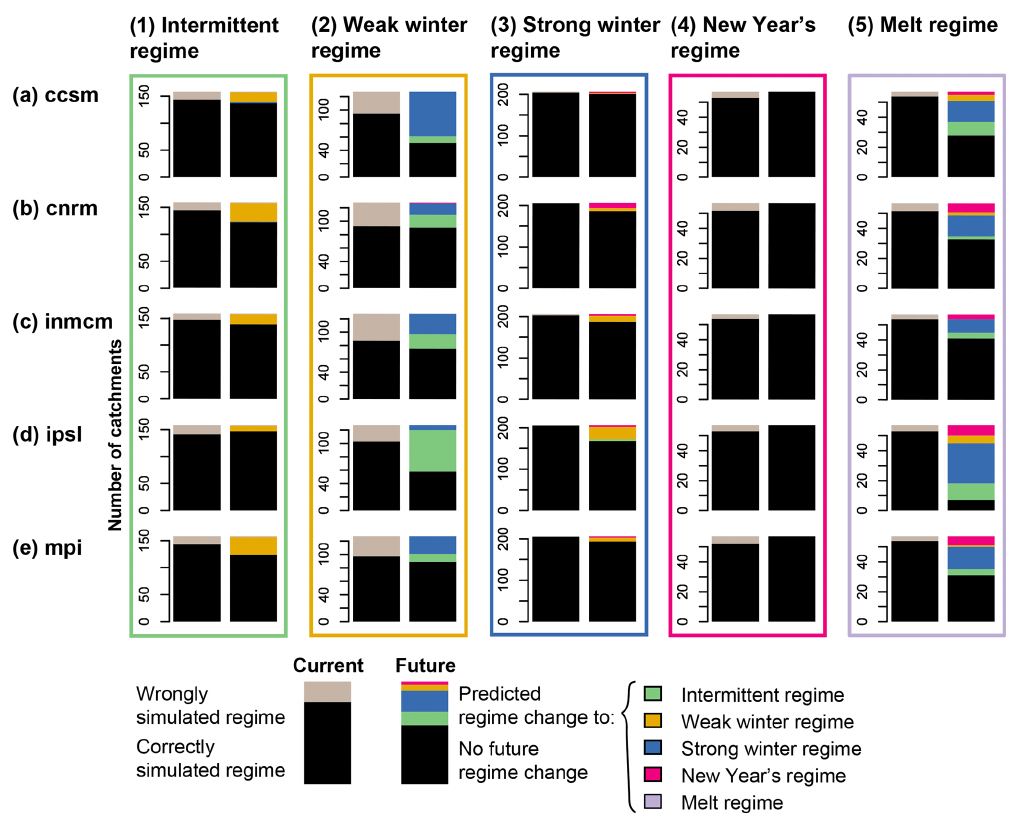
Figure 6. Current regime simulation error and future predicted regime changes for the five regimes, (1) intermittent, (2) weak winter regime, (3) strong winter regime, (4) New Year’s regime, and (5) melt regime, and the five GCMs, (a) ccsm, (b) cnrm, (c) inmcm, (d) ipsl, and (e) mpi. The number of catchments where the reference simulations result in the observed regime class and a wrong regime class are given in black and grey, respectively. The number of catchments with no predicted regime changes is given in black; the direction of change for the catchments with predicted changes is indicated by the respective regime